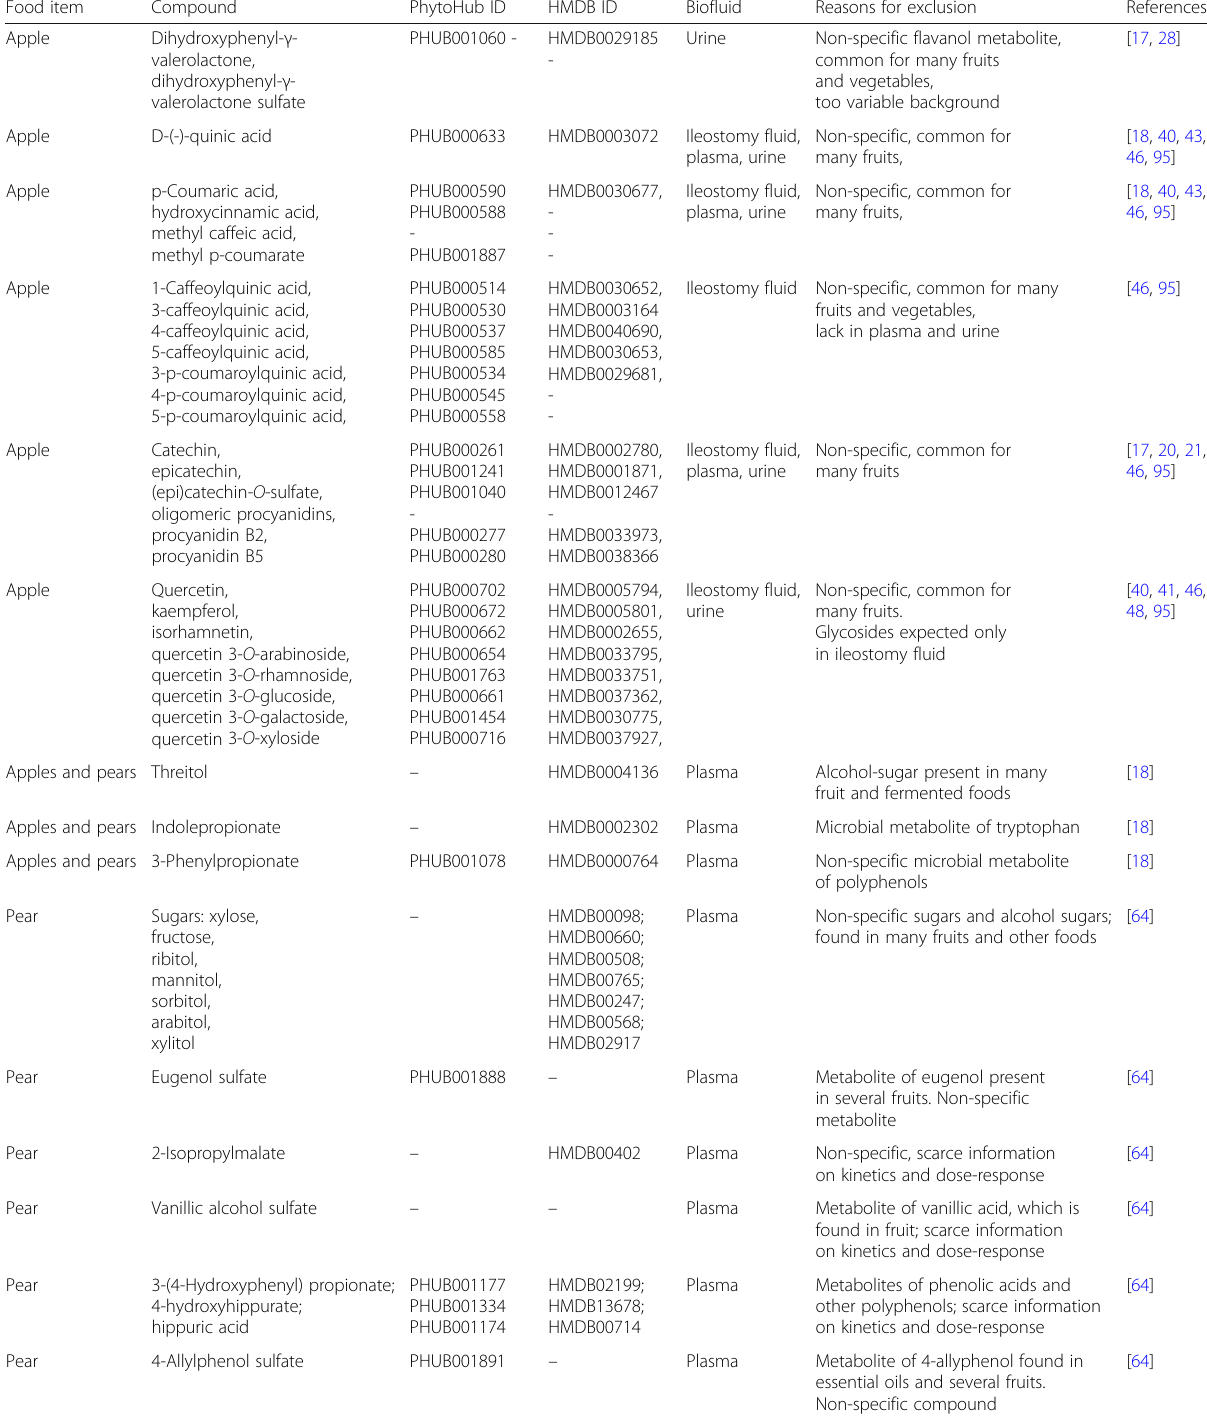
Table 2 List of non-retained compounds for pome